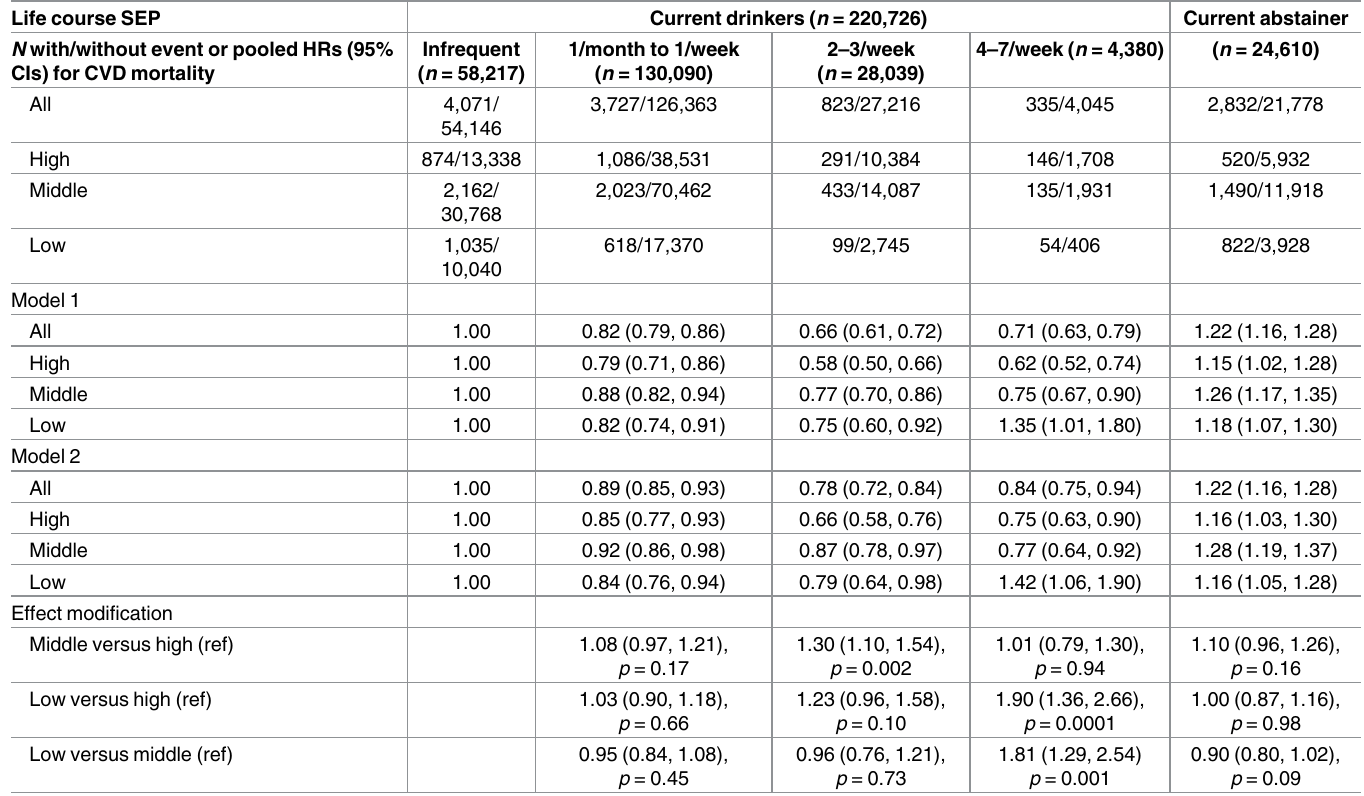
Table 2. Cardiovascular mortality according to alcohol consumption frequency using multiple imputation ( n = 245,336).